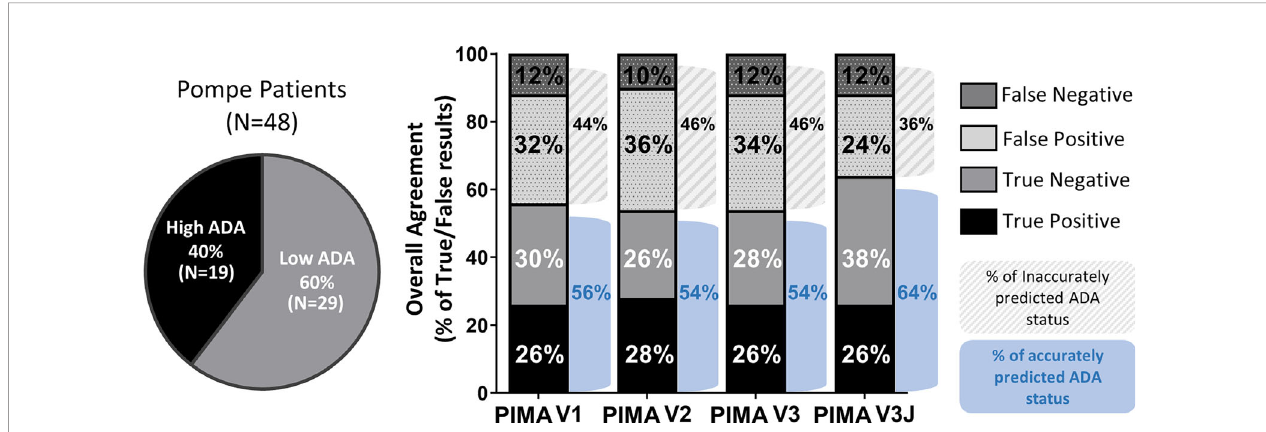
FIGURE 3 | Overall agreement of the four PIMA scoring algorithms as predictors of ADA status. Among the 48 IOPD subjects evaluated, 19 (40%) developed high ADA titers; this includes subjects with high and sustained antibody titers (HSAT) as well as sustained intermediate titers (SIT). The remaining 29 subjects (60%) developed low ADA titers. PIMA V1 (previously published) accurately predicted the ADA status for 56% of the IOPD subjects. Versions V2 and V3 accurately predicted 54% of subjects, thus further adjustment was explored. Adjusting for potential Treg epitopes with V3J improved accuracy to 64% of the